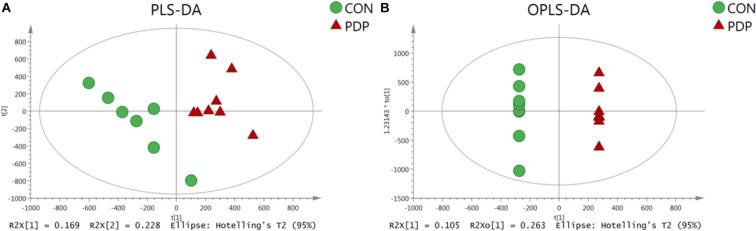
The PLS-DA (A) and OPLS-DA (B) scores plot of muscle metabolites from the control (CON) and pedal peptide-type neuropeptide injected (PDP) groups. The abscissa and ordinate represent the first principal component (PC1) and the second principal component (PC2), respectively.